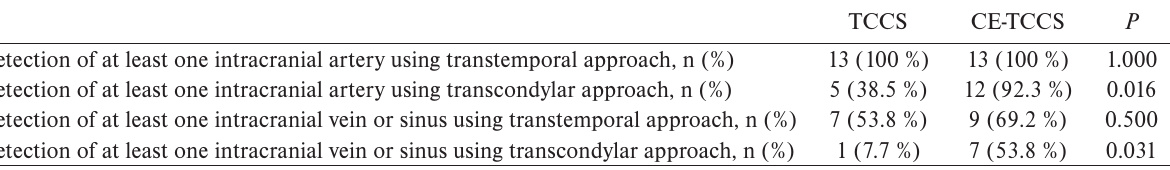
Table 4. Comparison of intracranial vessels detection between transcranial color-coded duplex sonography (TCCS) and contrast enhanced transcranial color-coded duplex sonography (CE-TCCS).